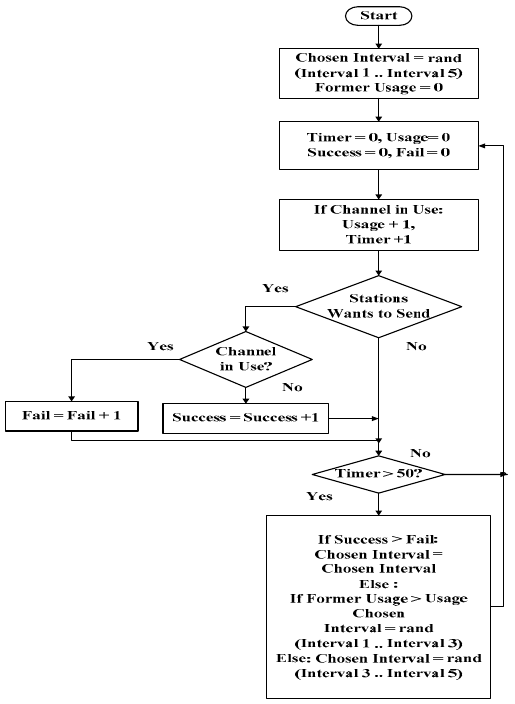
Figure 1. Back-Off Time Optimization based on the Tabu Search Algorithm.